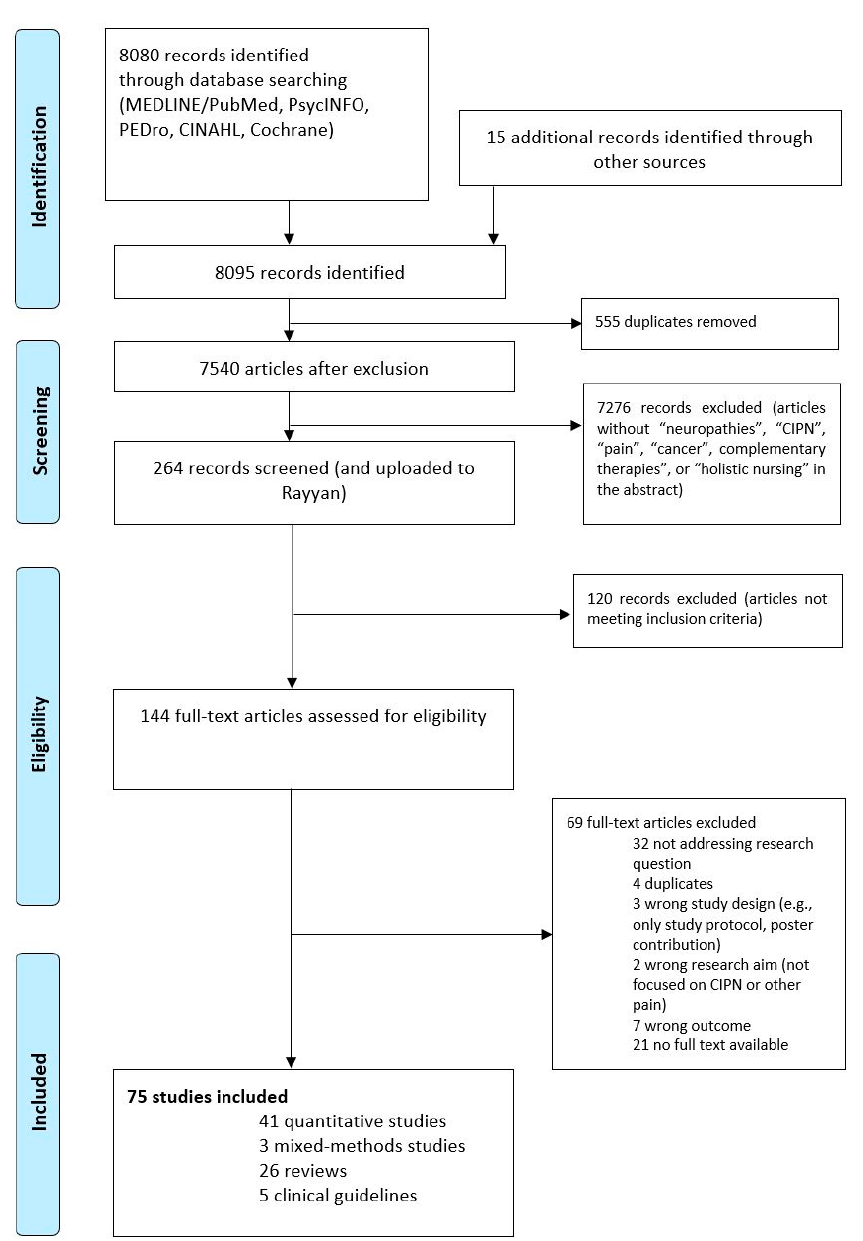
Figure 1. Flowchart of article selection process.